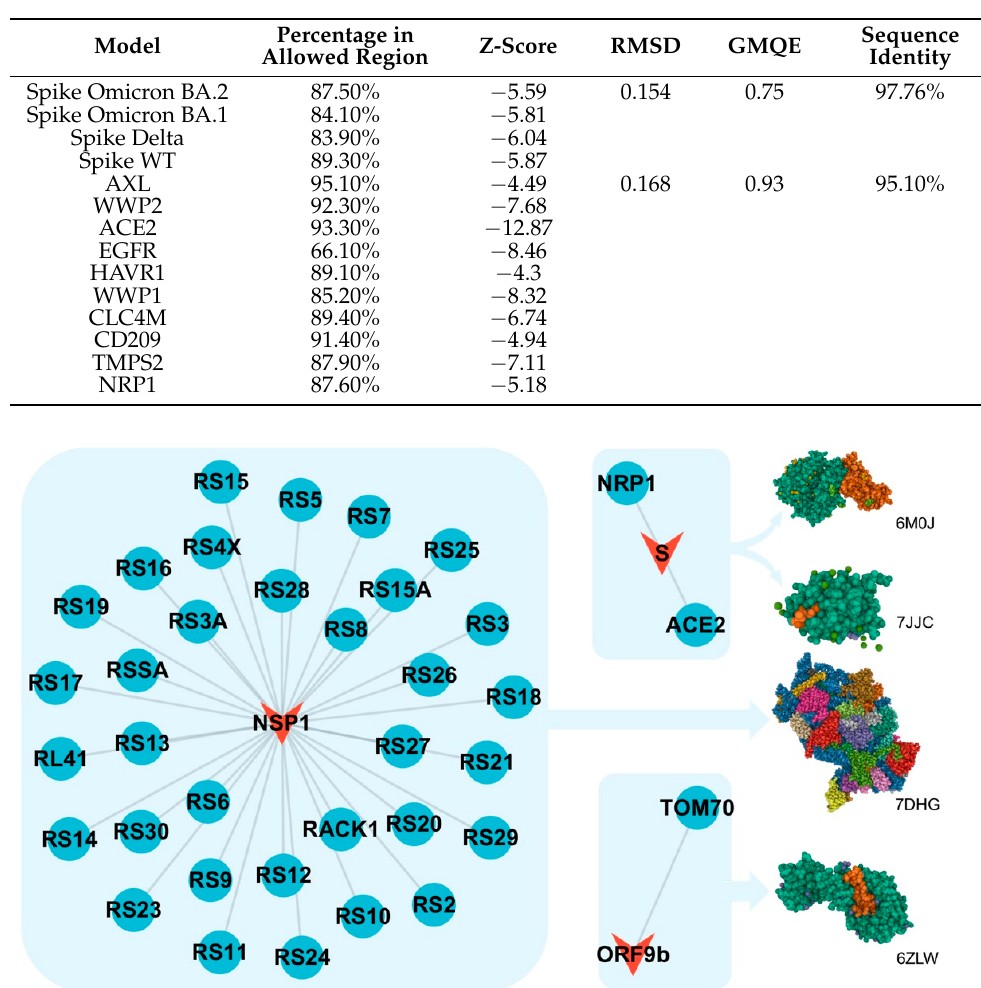
Figure 3. The experimental SARS-CoV-2–human binding structures mapped to PPIs and PPI clusters. Mapped structures are: S protein’s receptor-binding domain (RBD) bound with ACE2 (PDB ID: 6M0J [31]); S protein’s RBD bound with NRP1 (PDB ID: 7JJC [10]); ORF9b complex with human TOM70 (PDB ID: 7DHG [44]); Nsp1 bound to the human 40S ribosomal subunit (PDB ID: 6ZLW